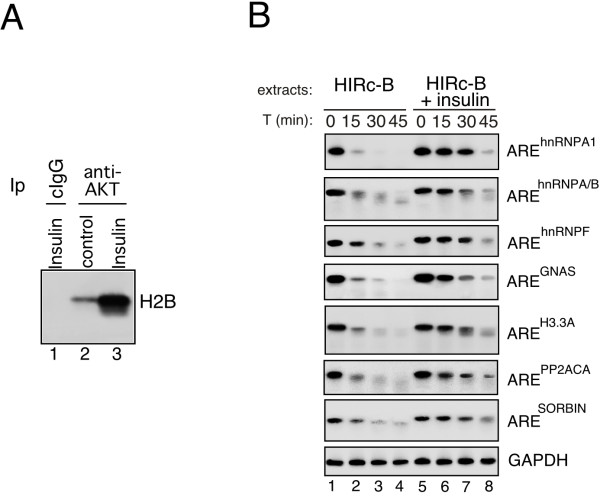
Insulin stabilizes a set of KSRP-interacting mRNAs. (A) Serum-starved HIRc-B cells were treated for 1 h with either PBS (control) or insulin (10-6 M). Total extracts were immunoprecipitated with either anti-AKT antibody or control IgG (cIgG). Pellets were incubated (20 min at 30°C) with histone 2B (H2B) in kinase buffer in the presence of γ[32P]ATP under gentle shaking. Labeled proteins were separated by SDS-PAGE and detected by autoradiography. (B) In vitro RNA degradation assays using S100 extracts from either control or insulin (10-6 M)-treated HIRc-B cells. Internally 32P-labeled, capped RNA substrates (see Additional file 4 for sequences) were incubated with S100 extracts for the indicated times and their decay analyzed as described in Methods.